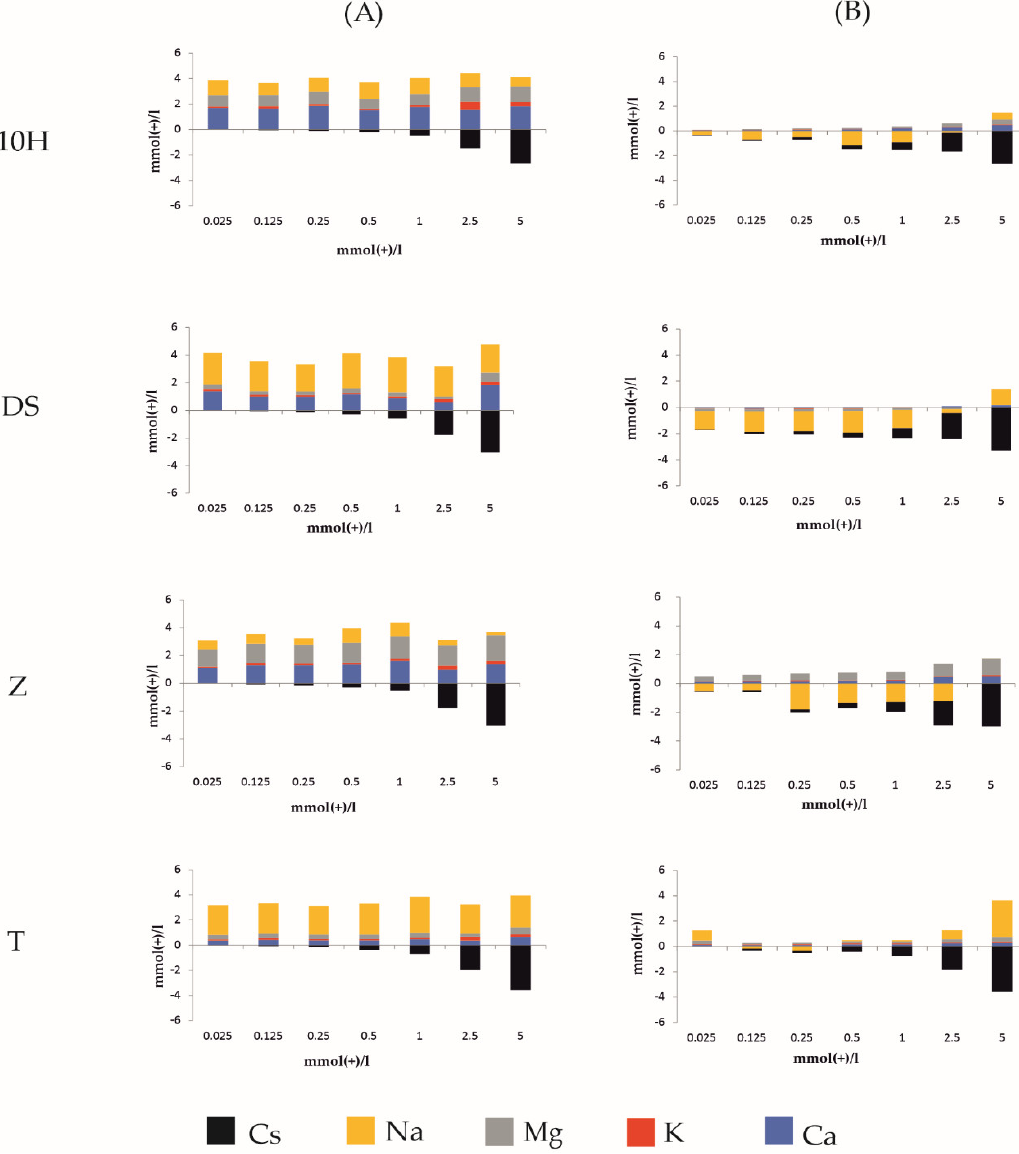
Figure 5. The number of cations released (+) and absorbed from the solution ( − ) depends on the initial concentration of the CsNO 3 solution at pH 3 ( A ) and 10 ( B ).